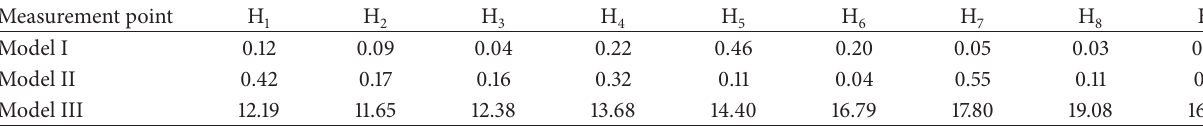
Table 2: Velocity amplitudes at H